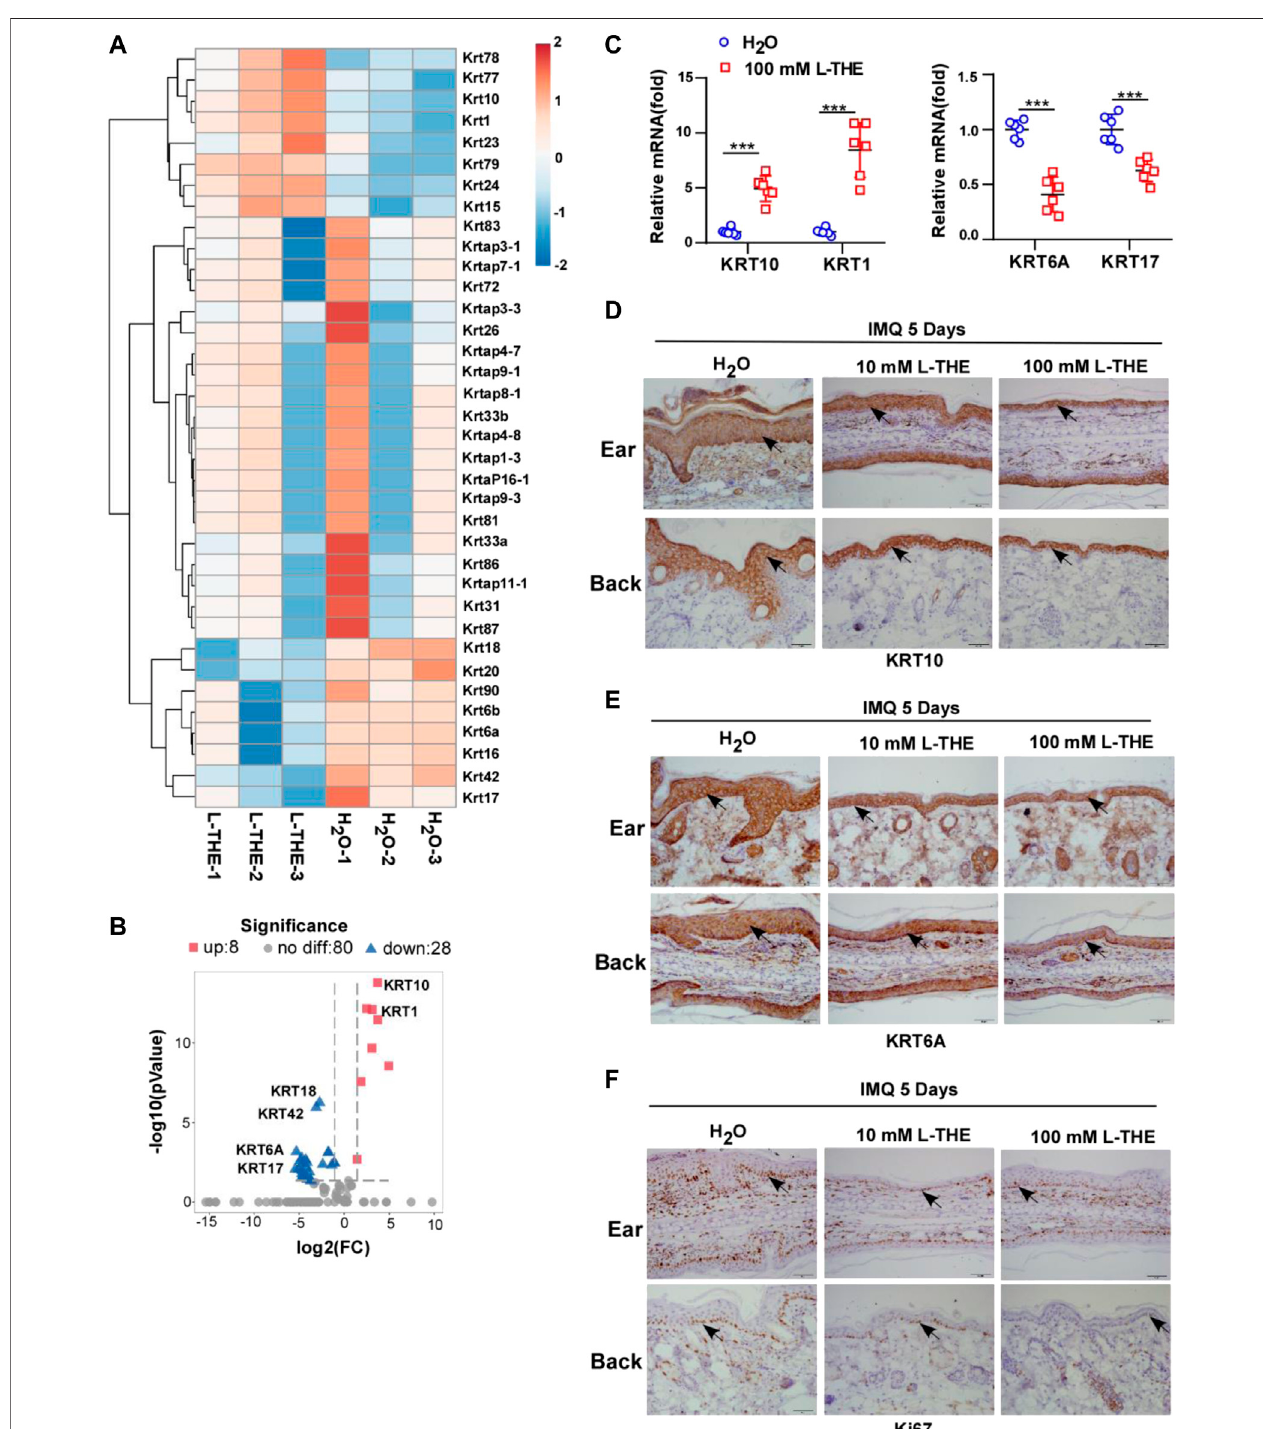
FIGURE 2 | L-THE regulates the expression of genes related to the proliferation and differentiation of keratinocytes. (A,B) Heatmap (A) and Volcano plot. (B) showed theexpression ofKRT genesbased on RNA-seq datafrom IMQ-inducedpsoriasis mice treated with100 mM L-THE or H 2 Ofor5days. (C) RT-PCR analysisof themRNAlevelsofKRT10,KRT1,KRT6A,andKRT17inIMQ-inducedpsoriasismice( n (cid:1) 6pergroup)treatedwith100 mM L-THEorH 2 Ofor5 days. (D,F) IHCstaining ofKRT10,KRT6AandKi67inearorbackskinsectionsobtainedfromIMQ-inducedpsoriasismice( n (cid:1) 6pergroup)treatedwith100 mM L-THEorH 2 Ofor5 days. Data is representative of three independent experiments. p values are determined by two-way ANOVA. *** p < 0.001.